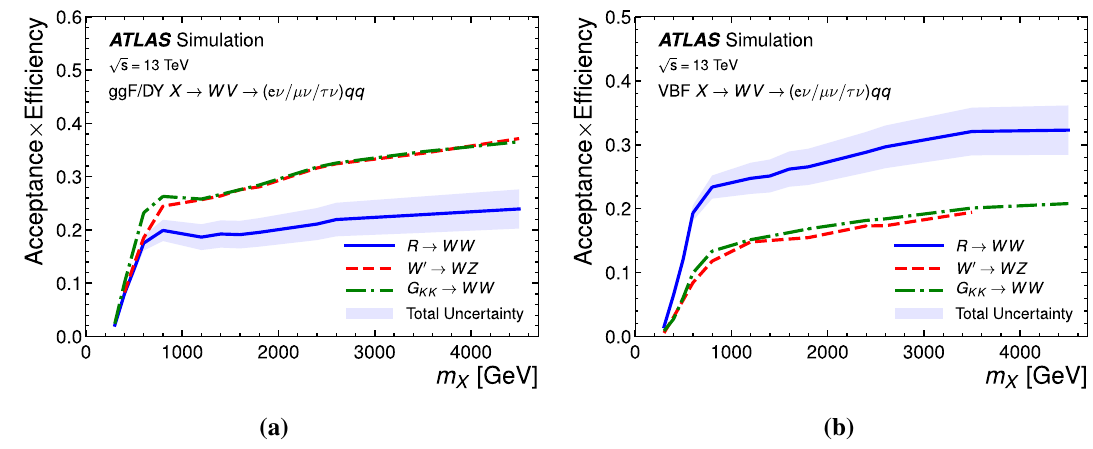
Fig. 7 Selection acceptance times efficiency for the X → WV → ( e ν/μν/τν) qq signal events from MC simulations as a function of the resonance mass for a ggF/DY and b VBF production, combining all SRs of both the resolved and merged analyses. Signal contributions from W → τν decays are included in the acceptance calculation. The